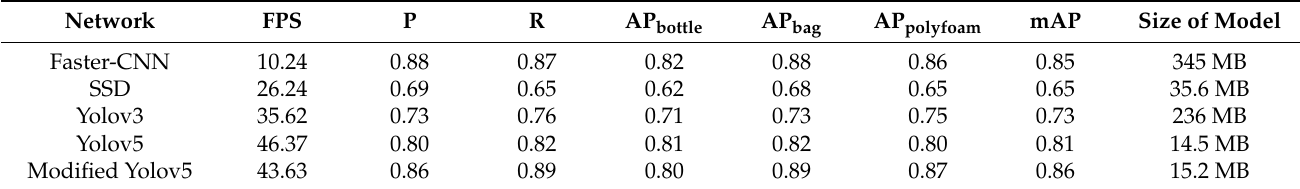
Figure 10. Marine litter monitoring results. ( a ) Plastic bottles; ( b ) polyfoam; ( c ) plastic bags. Table 1. Detection results of the